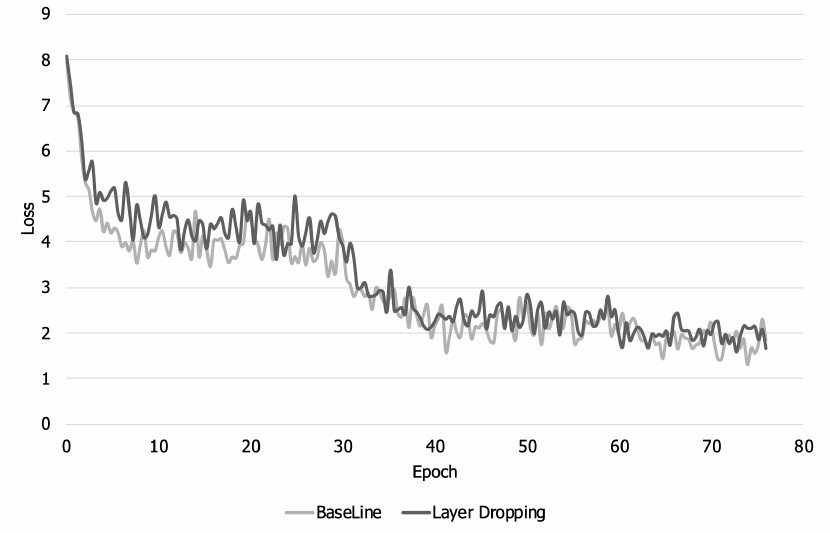
Figure 10. Training loss per epoch in a high bandwidth network.